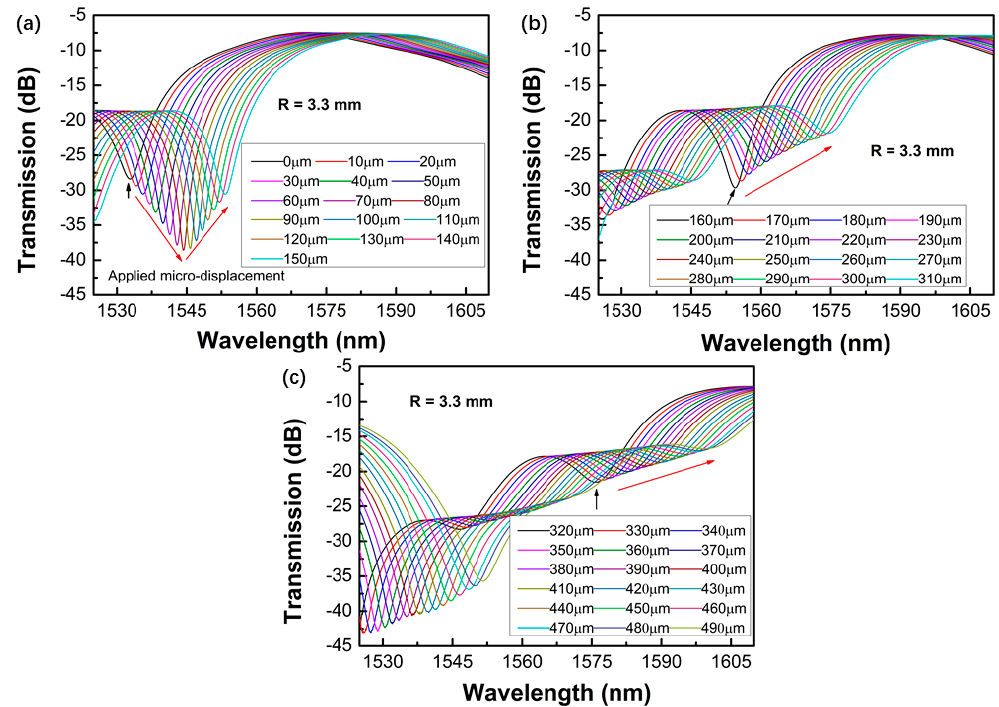
Figure 5. Transmission spectra of the proposed sensors varied with the displacement ranges of 0–150 µ m ( a ), 160–310 µ m ( b ), and 320–490 µ m ( c ) for the bending radius of 3.3 mm.